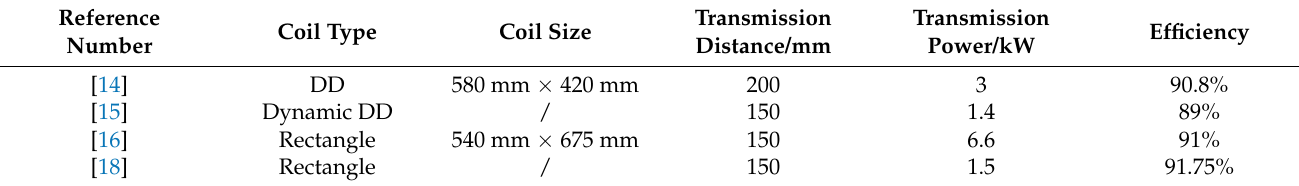
Table 1. Comparison of existing working parameters.